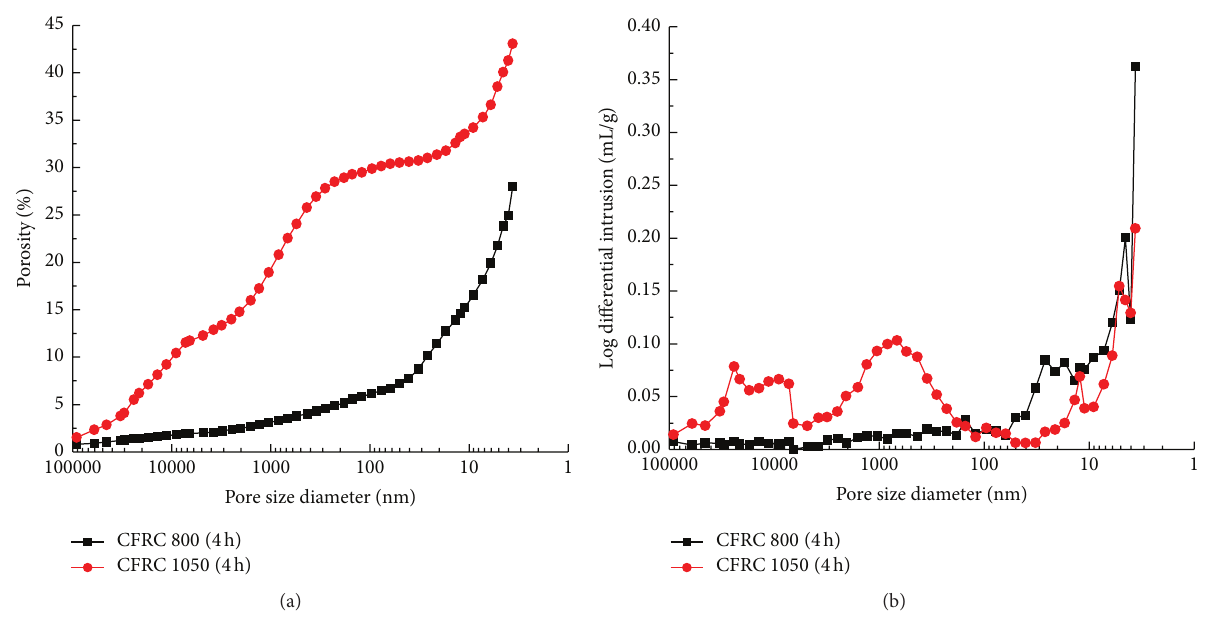
Figure 17: Pore size distributions of CFRC after heating at 800 ∘ C and 1050 ∘ C for